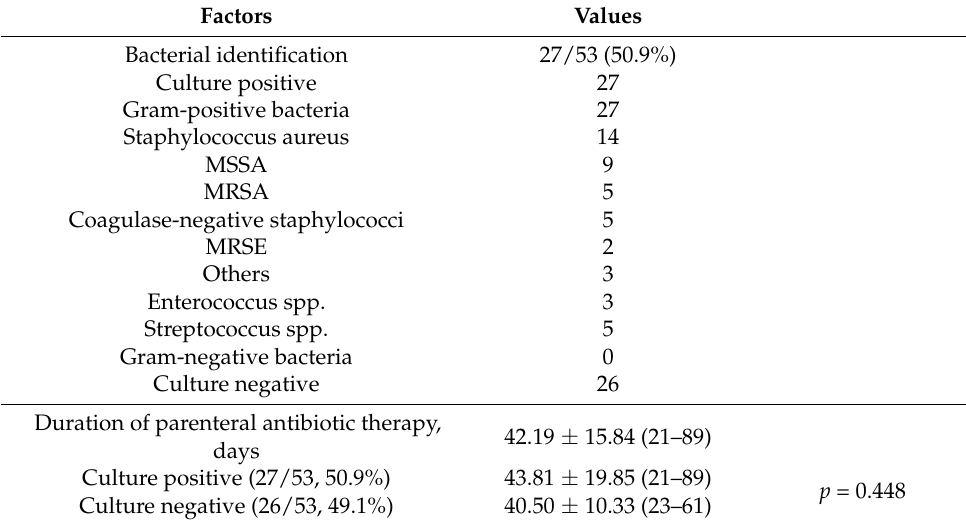
Figure 2. The overall clinical assessments and its decisions for therapeutic response during parenteral antibiotic therapy. PVO, pyogenic vertebral osteomyelitis; 18 F-FDG-PET/MRI, 18 F-fluorodeoxyglucose positron emission tomography/magnetic resonance imaging. Table 2. Characteristics of bacteriology and